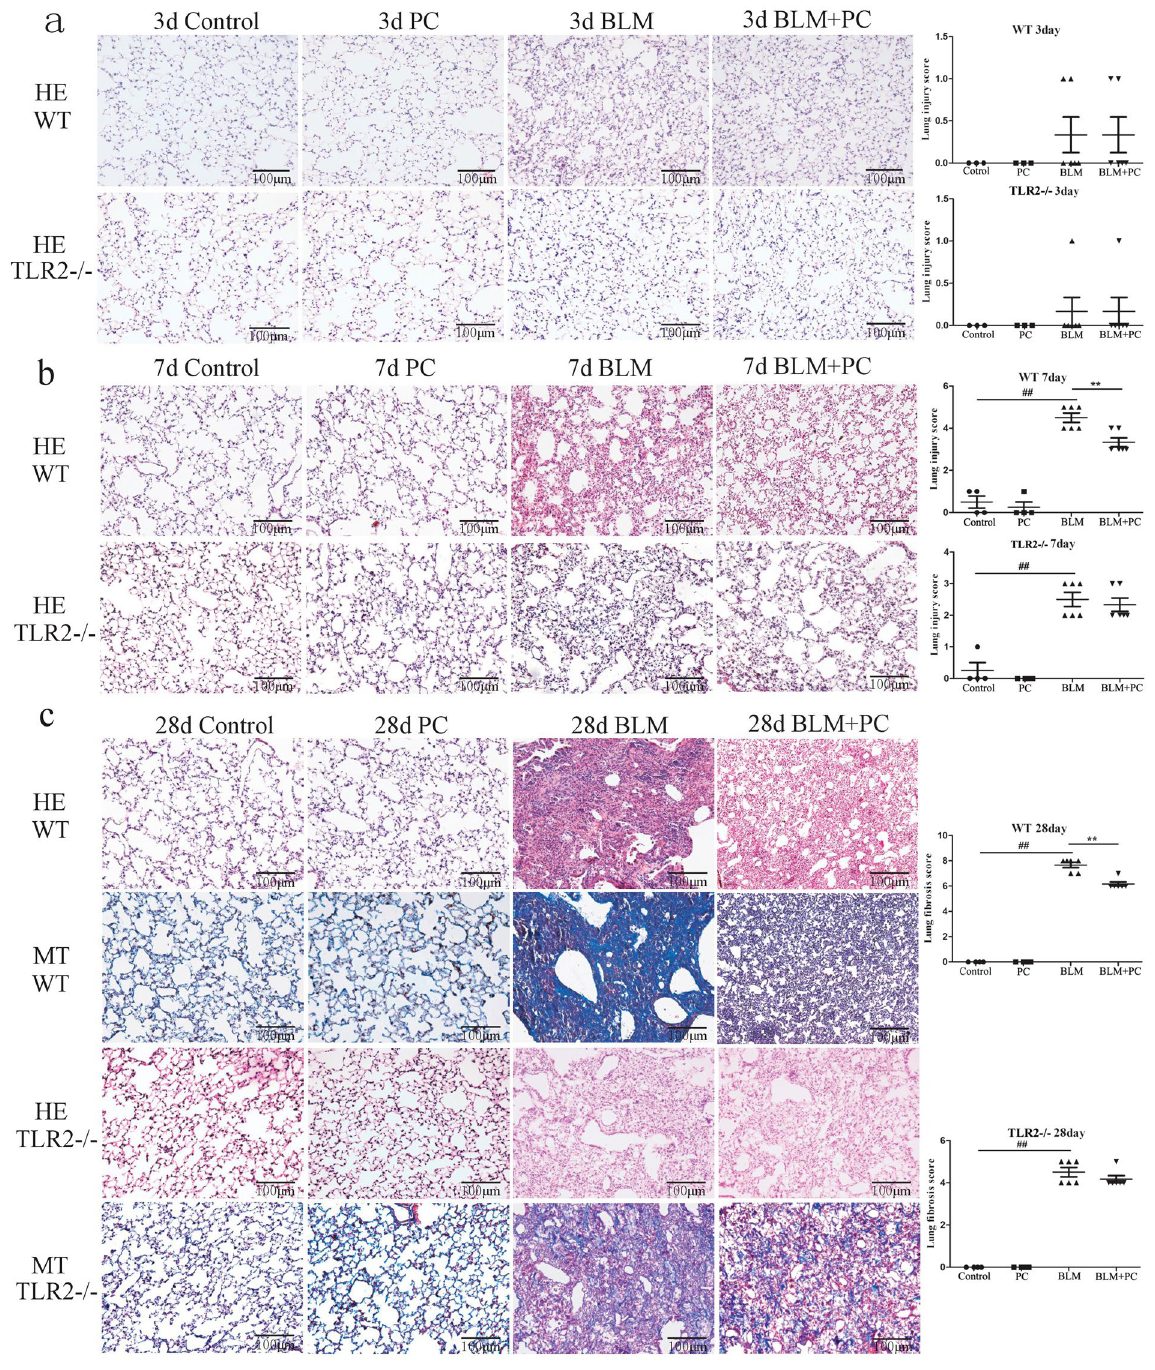
Figure 1. PC attenuated BLM mediated histological changes in mice. Lung tissue sections of control group, PC group, BLM group and BLM + PC group in different phases post-BLM treatment (5 mg/kg) in WT and TLR2 − / − mice separately. Severity of lung injury and fibrosis was analysed by the related scoring system. Each bar represents the mean ± SEM of 6–8 mice. ## p < 0.01 compared with the control group. ** p < 0.01 compared with the BLM group. ( a ) HE stain at 3 day. ( b ) HE stain at 7 day. ( c ) HE and Masson stain at 28 day. (HE and Masson’s trichrome stain, magnification 200 ×